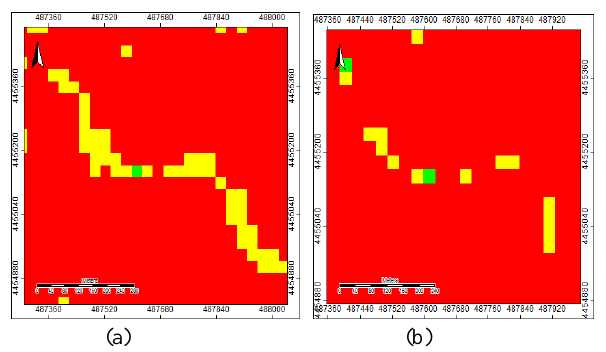
Figure 9. Differences in the mapping of the stream (a) FLS